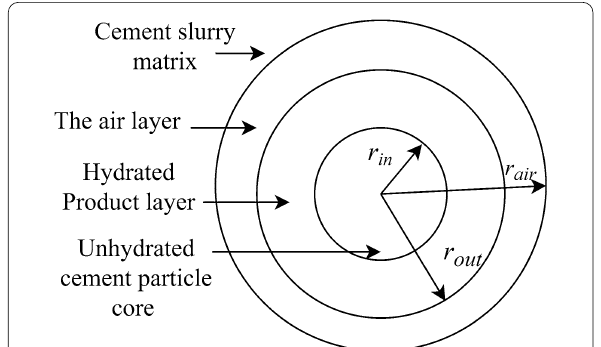
Fig. 1 Cement hydration